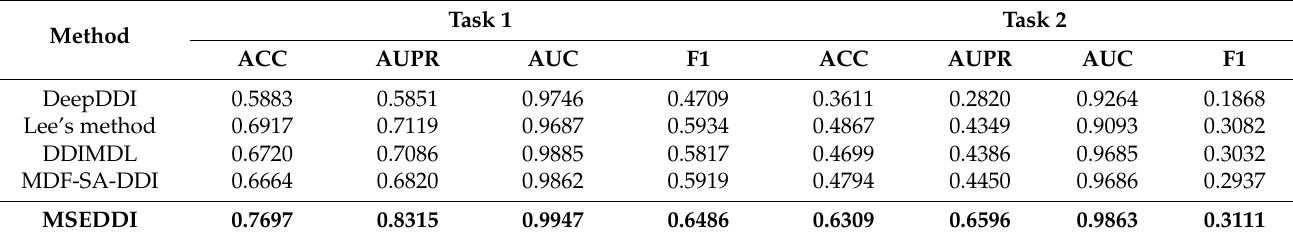
Table 2. The performance of all methods on Dataset